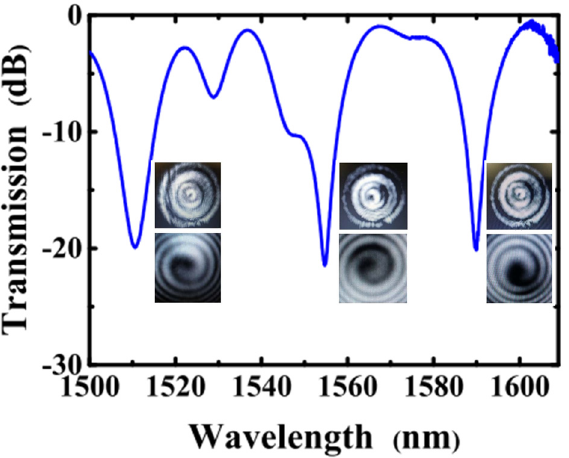
Figure 24. The measured transmission spectrum of one typical 3-channel HLPG, where the insets show the intensity and phase distributions of the OAM-1 mode observed at three different wavelengths, respectively. © [2021] IEEE. Reprinted, with permission, from Ref. [66].